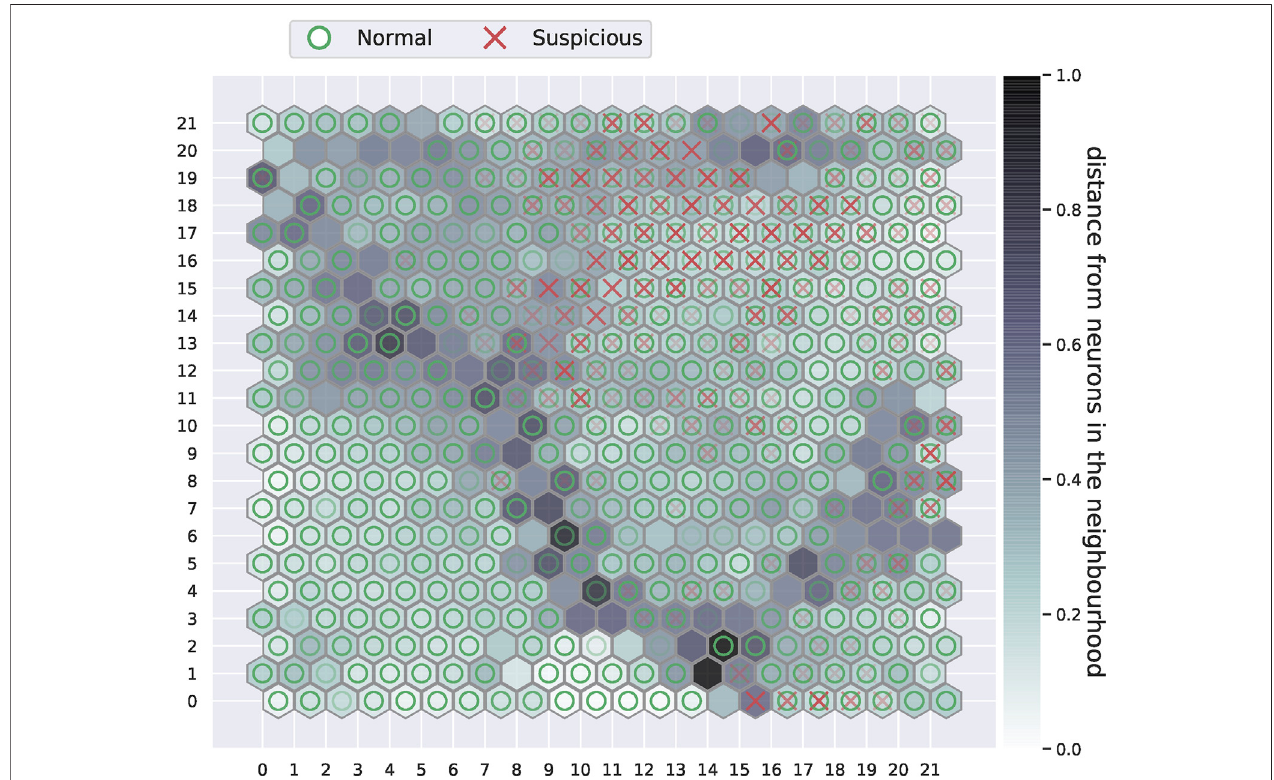
FIGURE3| Theself-organisingmapplotaftertraining.Darkgreycellsintheplotrepresentneuronsthatarefurtherawayfromtheirneighbouringneurons,whilethe lightgreyorwhitecellsarethosethatareincloseproximitytotheirneighbours.Darkerintensitymarkersofeithertheredcrossesorgreencirclesindicatetheattributionof many observations of the same class to a given neuron.